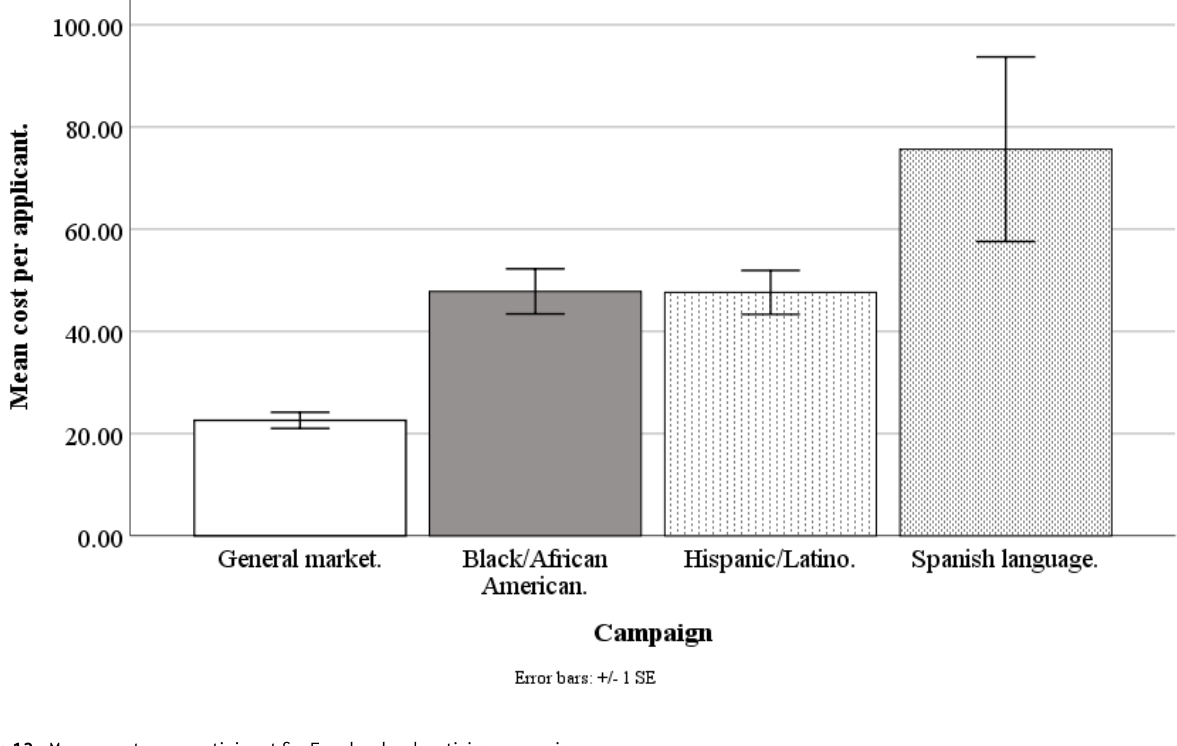
Figure 12. Mean costs per applicant for Facebook advertising campaigns.